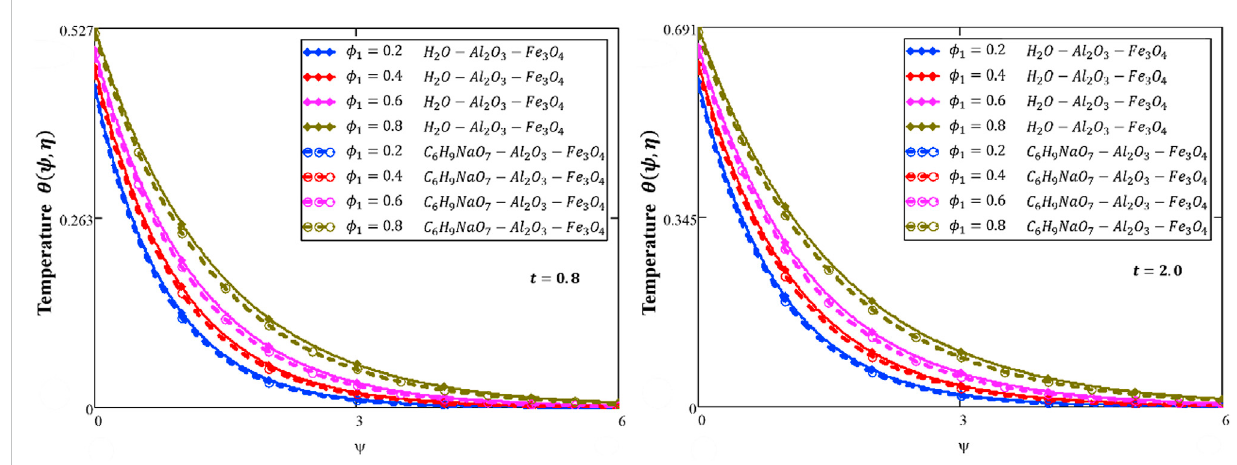
FIGURE 4 Simulation to explain the temperature for fl uctuating ϕ 1 when Pr (cid:3) 6 , α (cid:3) 0 . 4 , and ϕ 2 (cid:3) 0 . 5.